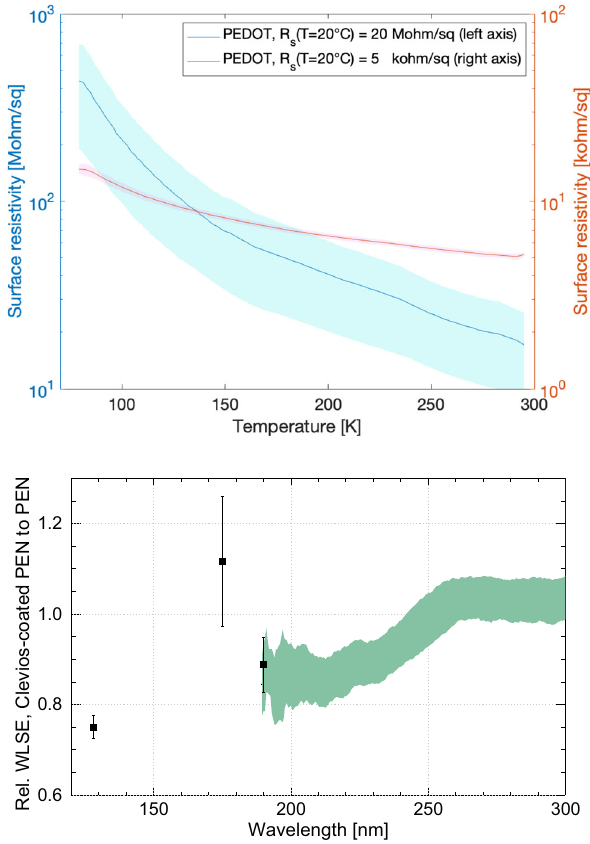
Fig. 2 Characterization of the PEDOT:PSS coating. (Top) Measure- ments of the sheet resistivity vs. temperature for two extreme cases, obtained from the average on different spots. Surface resistivities on the range of 10–1000 M (cid:4) /sq are interesting because they offer spark quenching, however they are thinner and less uniform (illustrated by the largererrorband).(Bottom)RatioofWLSEmeasurementsofPENfoils with and without PEDOT:PSS electrodes. Performed using a Shimadzu UV-3600 spectrophotometer equipped with an integrating sphere in a diffuse reflection configuration (green band) and with a fixed-detection- angle vacuum monochromator setup (black